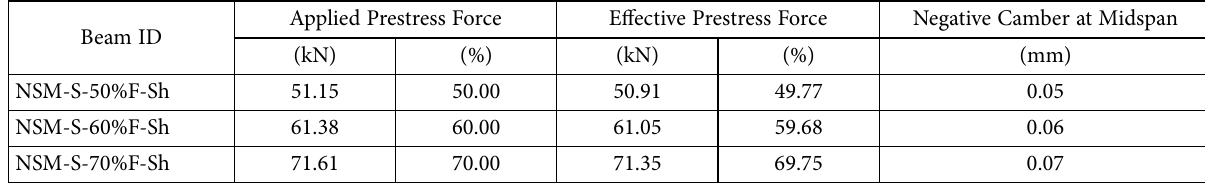
Table 3. Prestressing force and camber effect in the CEBPNSM strengthened beams Beam